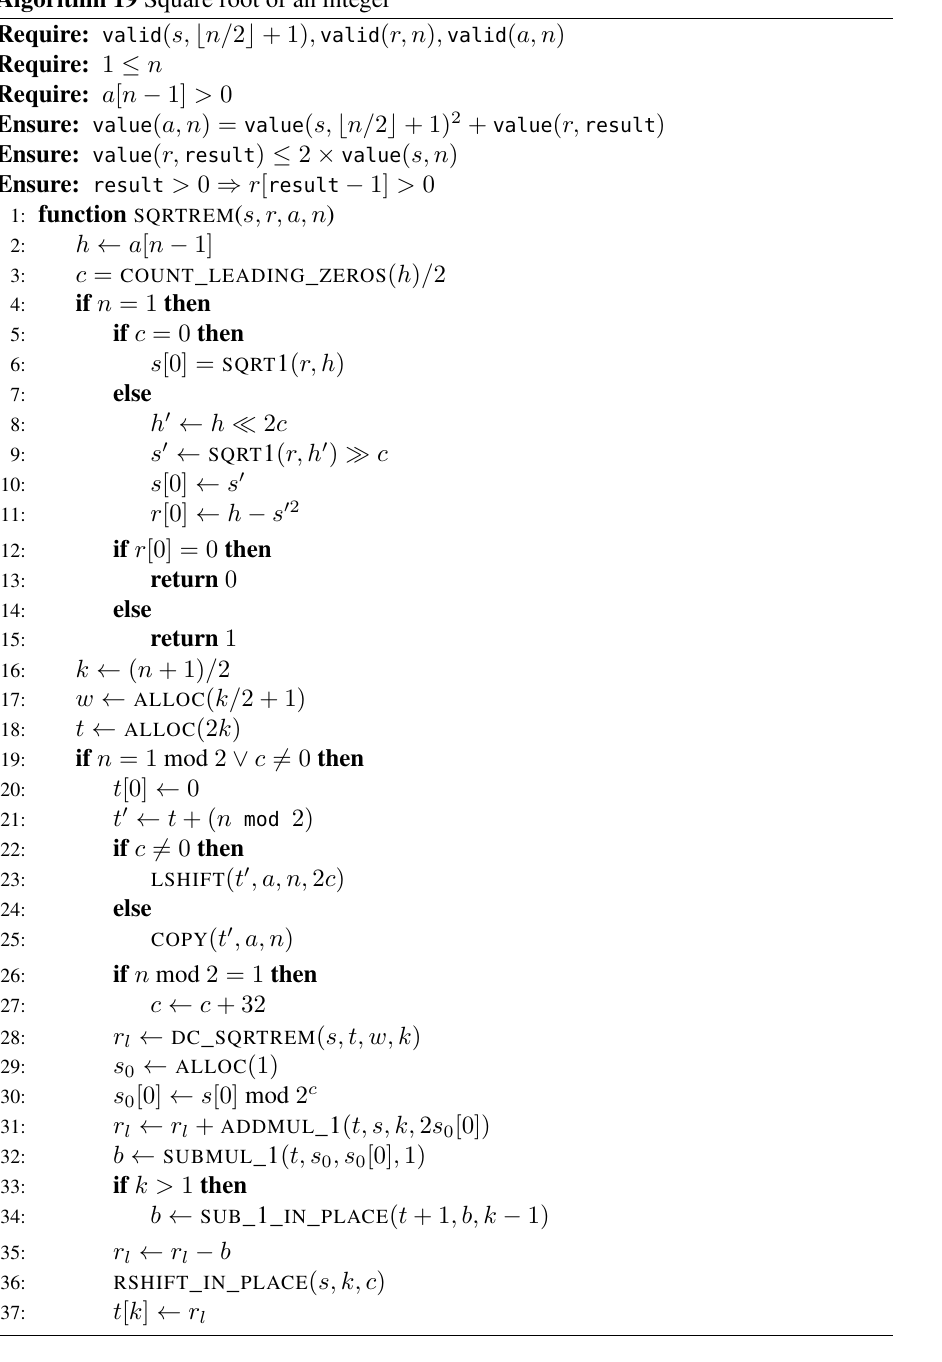
Algorithm 19 Square root of an